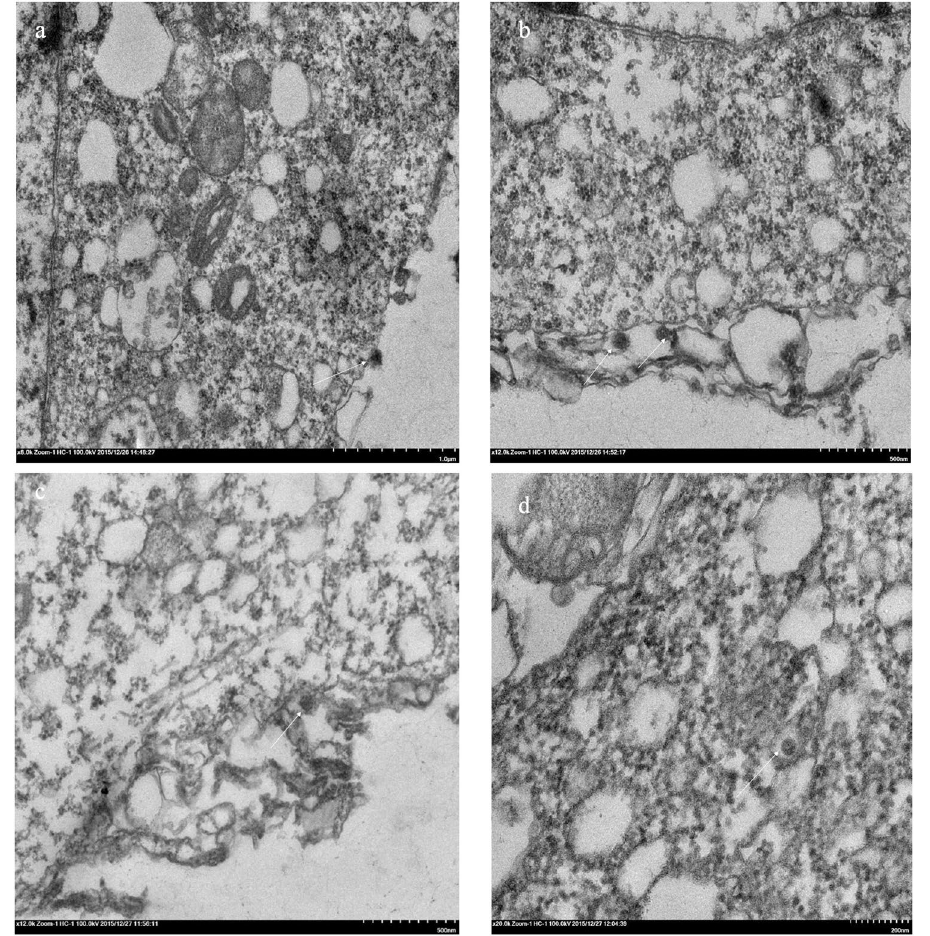
Figure 1. Electron microscopy observation of the early stage of BmCPV infection. ( a and b ) Attachment of BmCPV particles to the membranes of BmN cells at 30 min p.i.; ( c ) BmCPV particles were invaginated into the plasma membrane at 1.5 h p.i.; ( d ) BmCPV particles were delivered into an endosome-like structure at 1.5 h